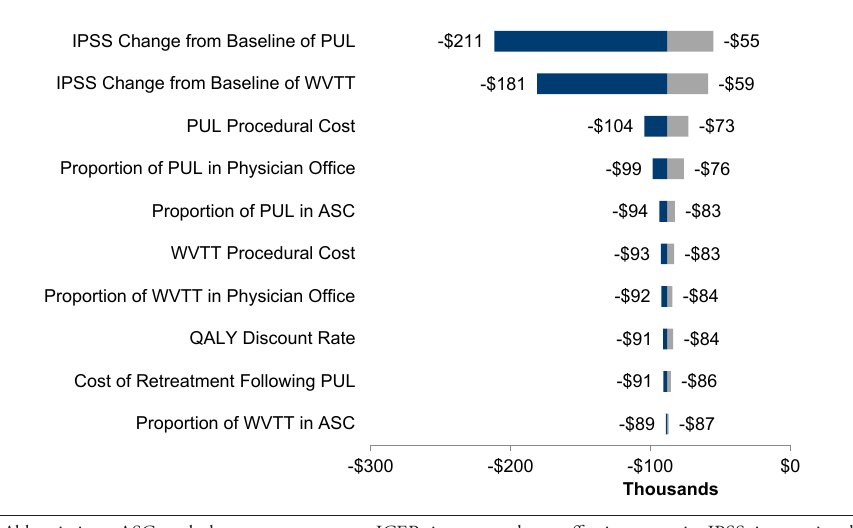
Figure 3. Tornado Diagram of One-way Sensitivity Analysis at 4 Years of PUL Versus WVTT